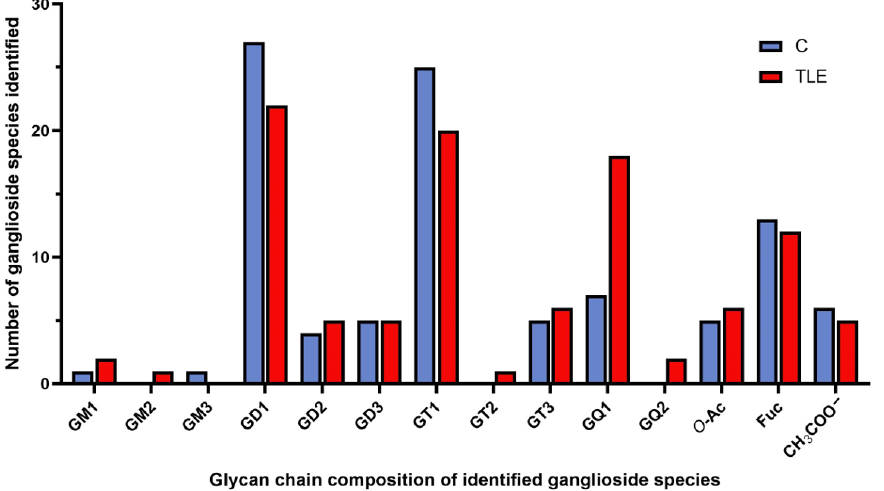
Figure 4. The distribution of the ganglioside species in TLE and control hippocampal tissue samples vs. their glycan chain composition.